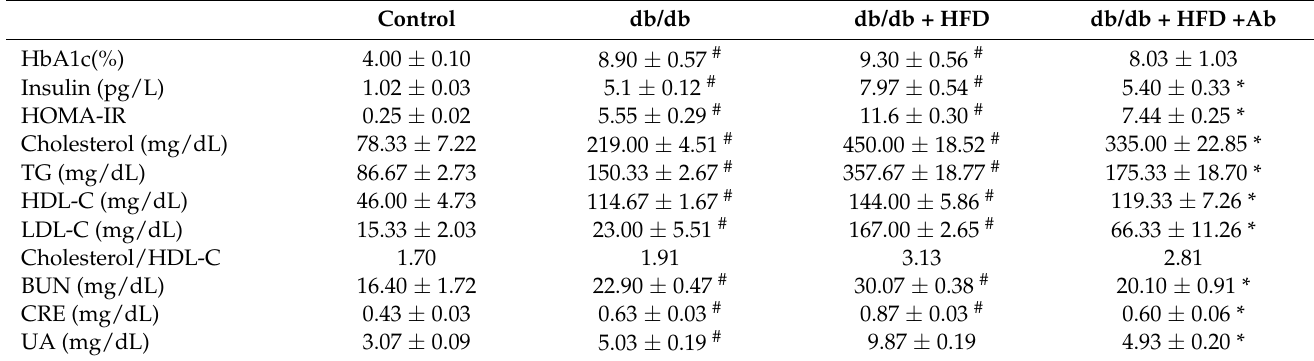
Table 1. The plasma biochemical parameters in HFD-fed mice treated with